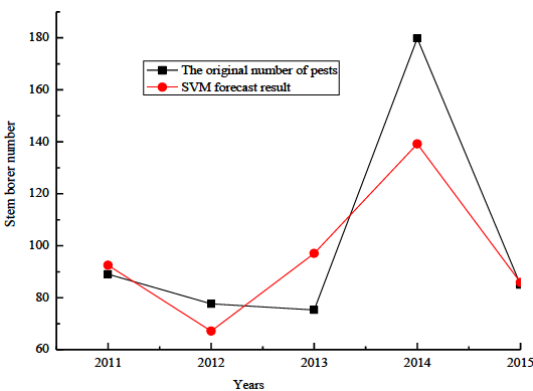
Figure 4: The prediction result of the stem borer number by SVM on the test set